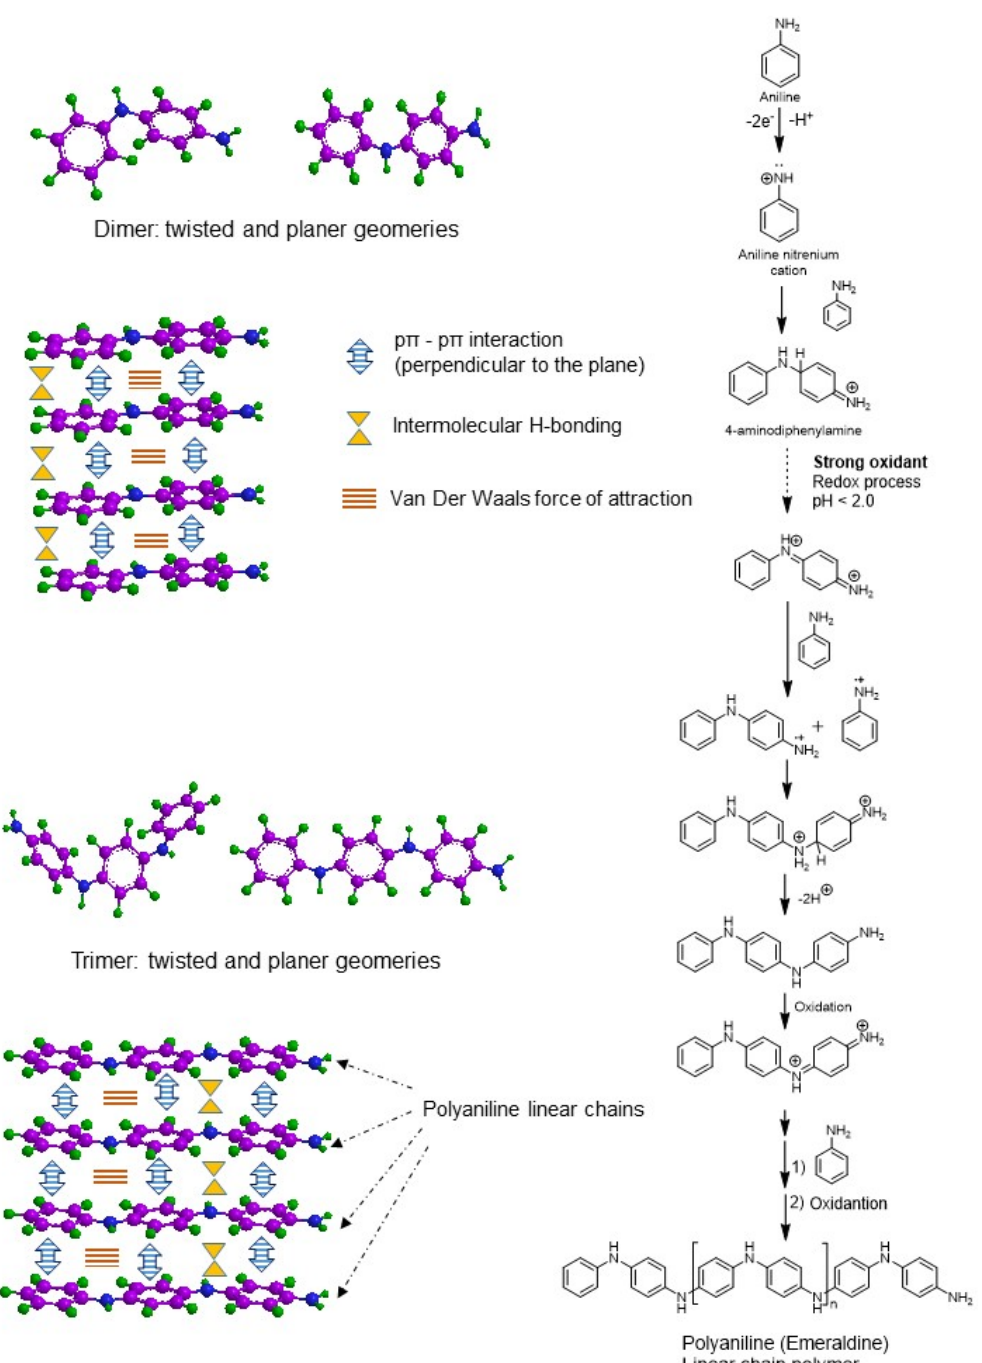
Figure 7. Mechanism of formation of aniline nitrenium cation, 4-aminodiphenylamine and “N-C 4 ” polyconjugated polyaniline via oxidative polymerization of aniline in the presence of S 2 O 82 − ions (ammonium peroxydisulfate). The interaction between the p π – p π orbitals resulting in overlapping of the orbital lobes helps in the formation of the crystalline lattice.